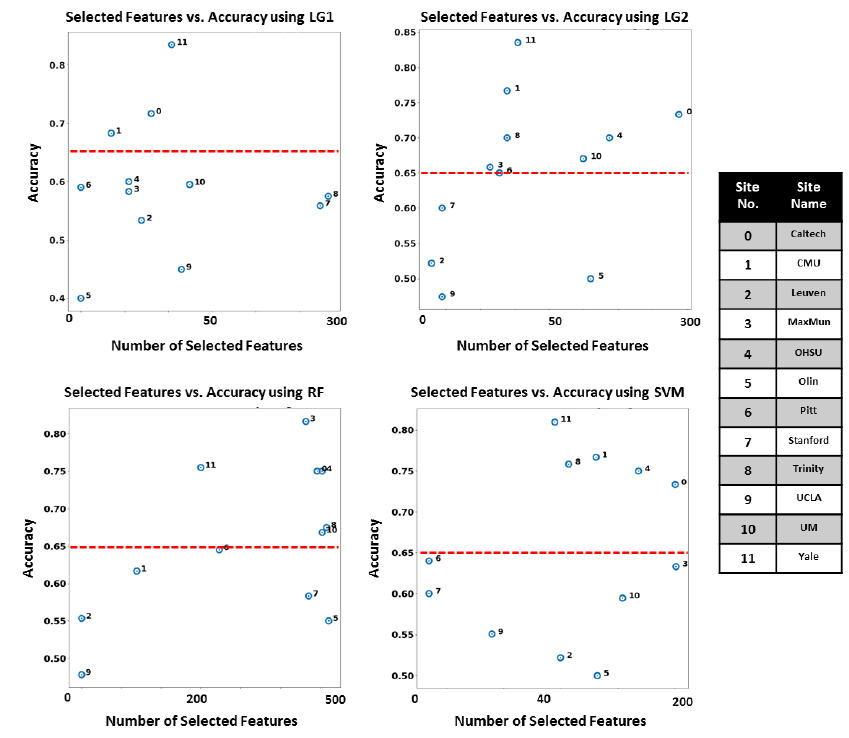
Figure 5. Number of selected features vs. the maximum balanced accuracy score achieved using these features when applying RFECV using the four core classifiers, using the local